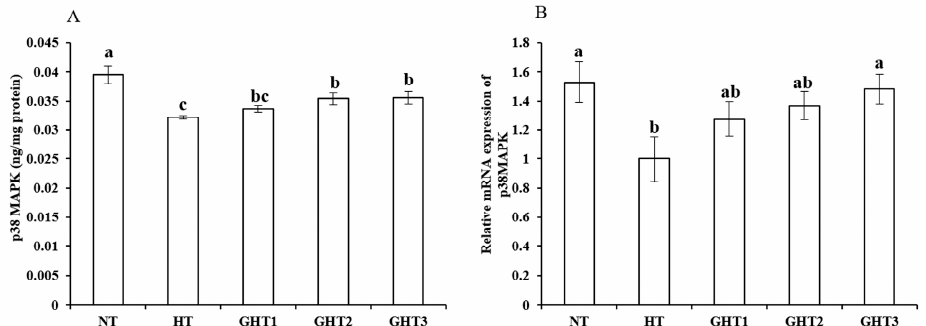
Figure 6. Effect of Gln on p38 MAPK protein ( A ) and gene ( B ) expression in the liver of broilers exposed to high temperature conditions. Different lowercase letters above each column indicate significant ( p <0.05) differences among the groups. NT group: Broilers were kept in the normal temperature environment and fed a basal diet. HT, GHT1, GHT2, and GHT3 groups: Broilers in these groups were kept in high temperature conditions and fed a basal diet supplemented with 0%, 0.5%, 1.0%, and 1.5% Gln.